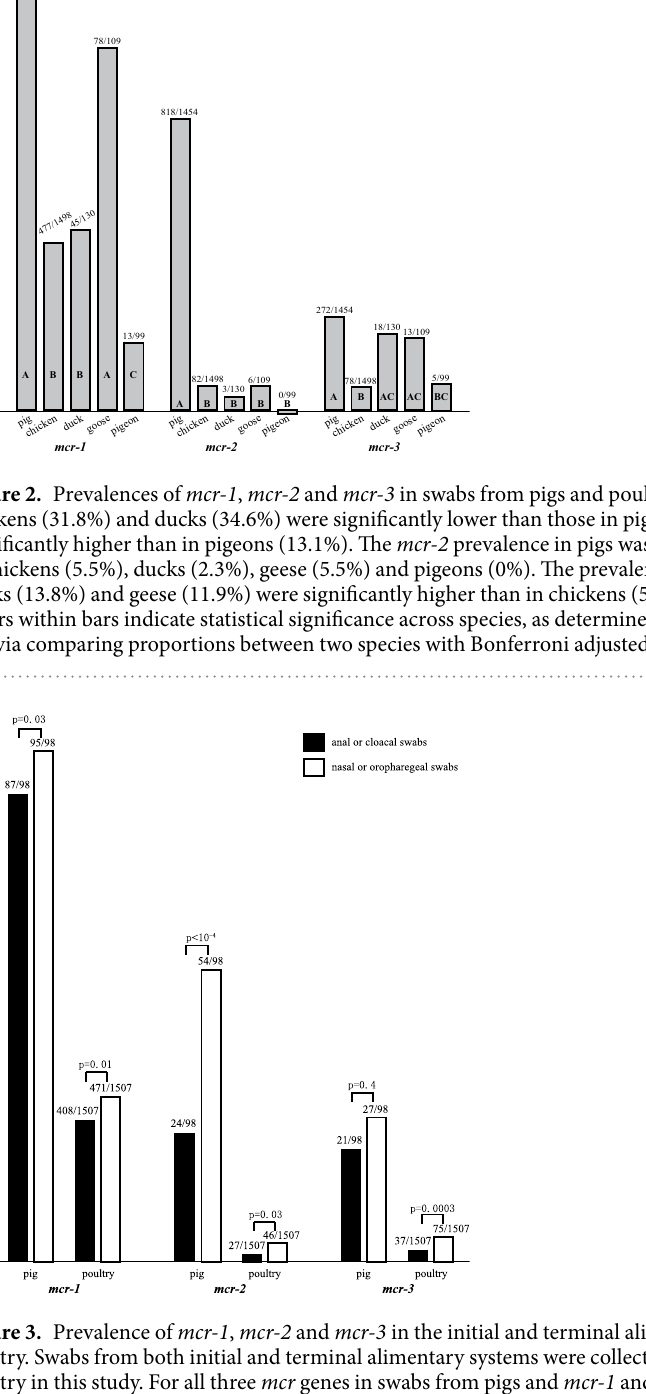
Three chickens were positive for mcr-1 , mcr-2 and mcr-3 . Both of the mcr-1 and mcr-2 were identified in 37 birds (31 chickens; 2 ducks; 4 geese) while 66 birds (48 chickens, 7 ducks, 9 gooses, 2 pigeons) were positive for mcr-1 and mcr-3 and 4 chickens were positive for both mcr-2 and mcr-3 (Table 2). Comparison of mcr between samples from initial and terminal alimentary systems. Swabs from both of the initial and terminal alimentary systems were collected from 98 pigs and 1,507 poultry. In general, the mcr prevalences in nasal/oropharyngeal swabs were significantly higher than in anal/cloacal swabs (Fig. 3). For the 98 pigs with both anal and nasal swabs available, 84 were mcr-1 positive in both samples, three had only positive anal swabs, and 11 only had positive nasal swabs. For the mcr-2 , only 13 pigs were positive in both swabs,